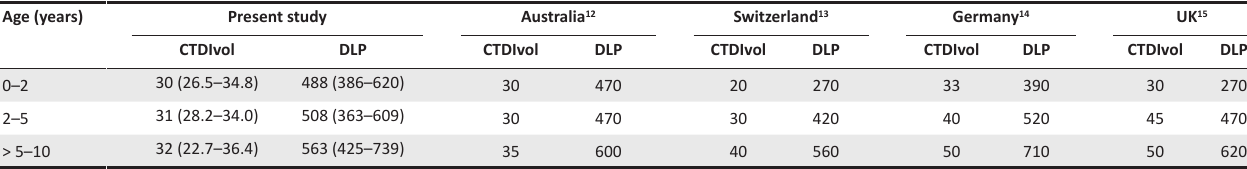
TABLE 2: Comparison of mean CTDIvol (mGy) † and DLP (mGy.cm) ‡ in the present study (2013), with international diagnostic reference levels (Australia, 2012 12 ; Switzer- land, 2005 13 ; Germany, 2006 14 ; and the UK, 2003 15 ). The year indicates the last year of data collection in each of the studies. All values are relative to the mean values from the present study. § 12,13,14,15 Ranges of corresponding values are in